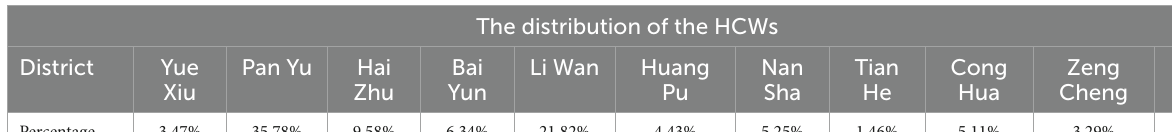
TABLE 1 The distribution in each district of the healthcare workers